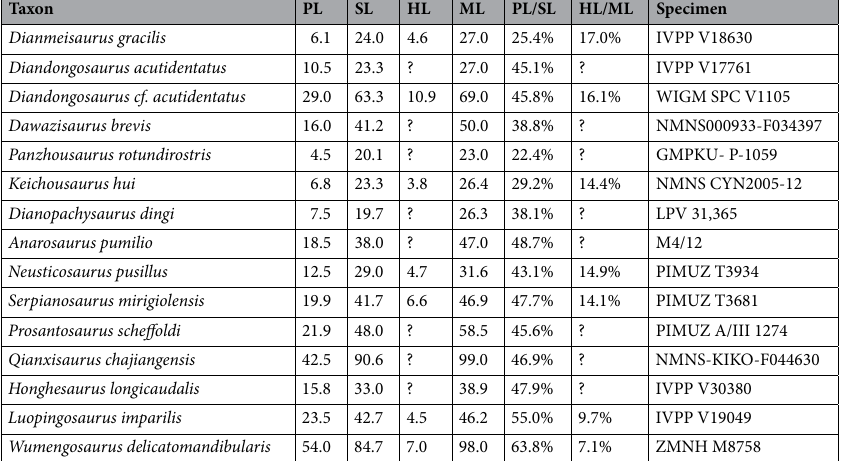
Table 2. Measurements (in mm) for cranial bones of pachypleurosauroids with relatively complete skeletons. HL, Hyoid length; PL, preorbital (snout) length; SL, skull length; ML, mandibular length; ?,